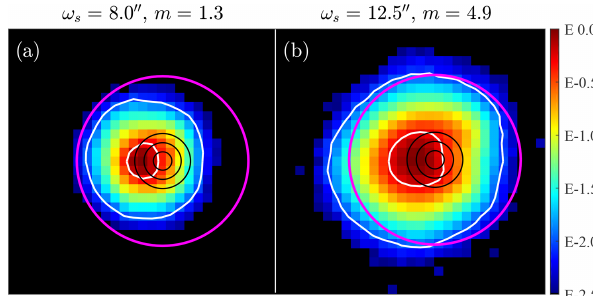
Figure C2. SPST09/C11 tracking of a 6s short-exposure high-star spot (a) and low-star spot (b) . These two illustrations represent high-resolution SBIG camera data that correspond to two Eureka points in Fig. 2 but whose respective air masses of 1.3 and 4.9 were obtained from the intersection of their ω s values with the blue re- gression line. The fluxes shown in panels (a) and (b) are normalized to their maximum flux (their log-scale colour legend is shown on the right). The FOV, the 1% and 50% flux levels, and the centring tol- erances are represented by a magenta circle, the two white contours, and the three black concentric circles (radius of 2, 4, and 6arcsec), respectively. The spots are horizontally shifted by a 4arcsec cen- tring error with respect to the FOV. (Note that “ (cid:48)(cid:48) ” denotes arcsec- onds in this